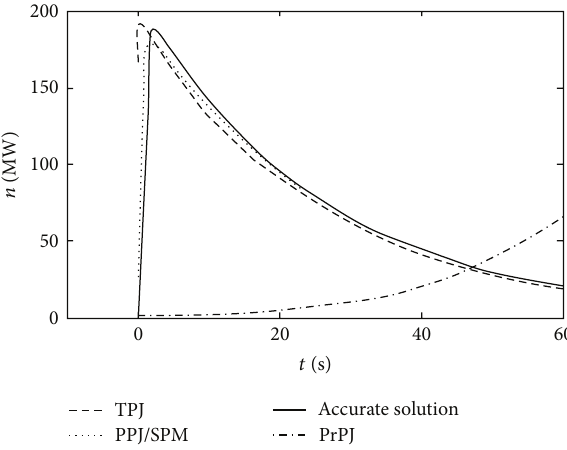
Figure 2: Variation of total reactivity with time while inserting step reactivity 𝜌 0 = 0.5𝛽 and 𝜌 0 = 0.8333𝛽 .